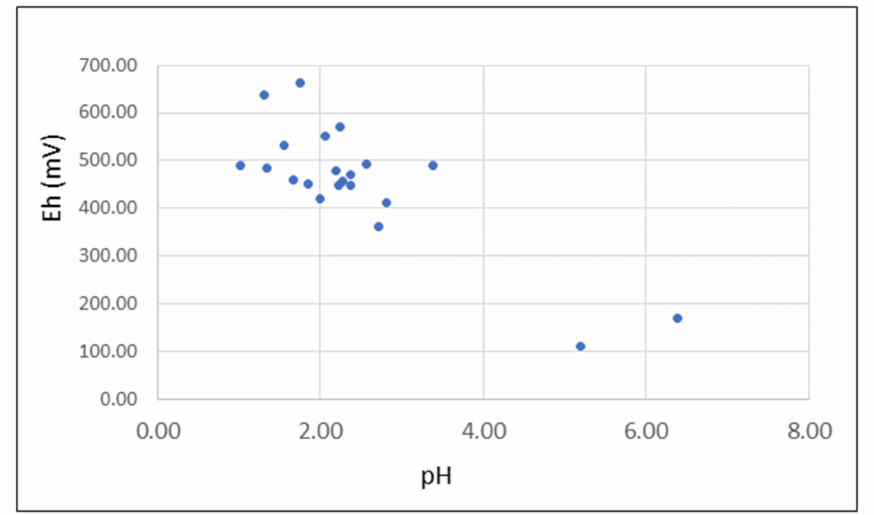
Figure 10. Scatter diagram plotting pH versus Eh (mV) headwater spring